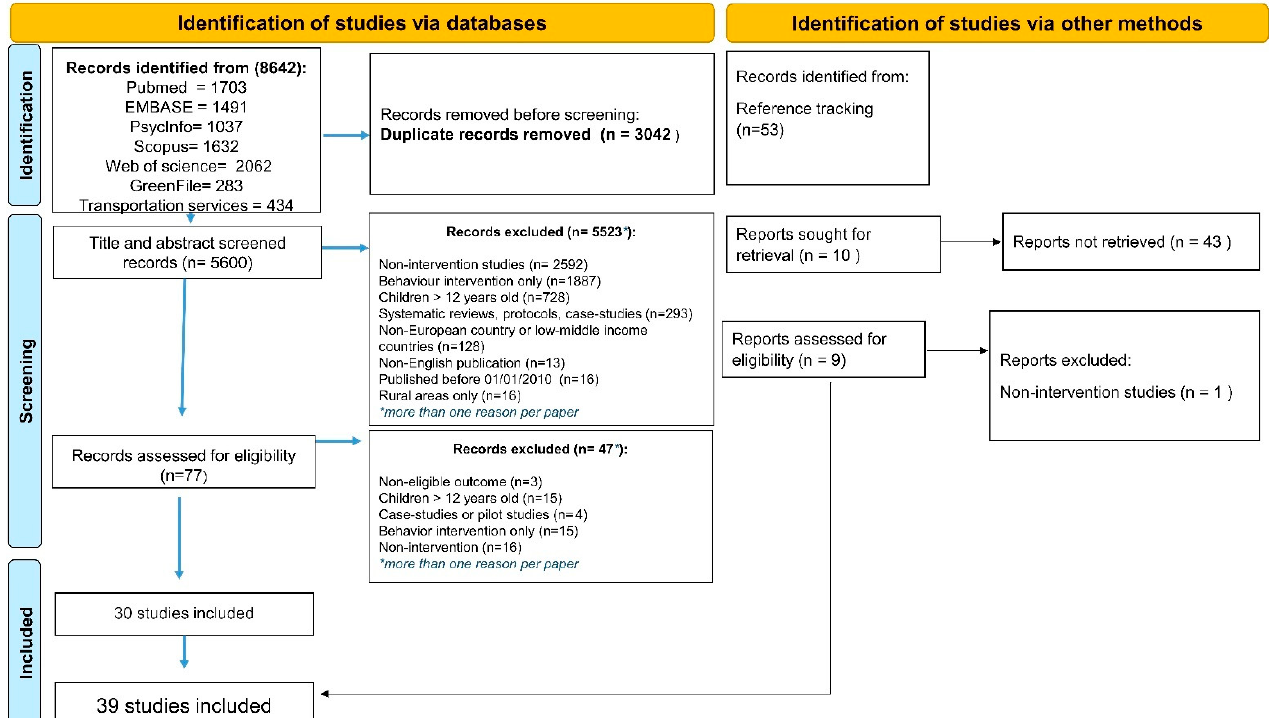
Figure 2. PRISMA flow diagram of study search and selection [40].